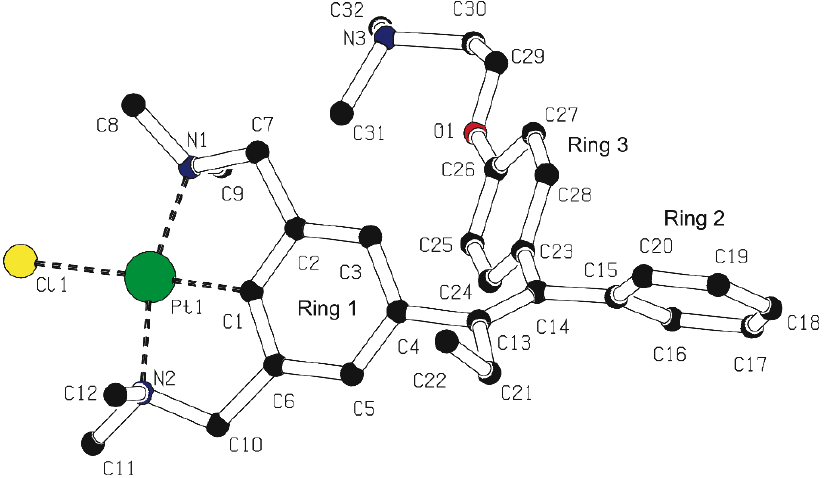
Figure 2. PLUTON visualization of 5b in the crystal [34]. Hydrogen atoms are omitted for clarity. In 5b , angles of 74.9(7), 48.6(7), and 88.4(6)° are found between the planes of ring 1 and ring 2, ring 1 and ring 3, ring 2 and ring 3, respectively. A dihedral angle of 52.5(7)° is found between ring 1 and the plane formed by C4, C13, C14, C21. Angles of 48.8(9) and 56.9(9)° are found for ring 2 and ring 3, respectively, with the plane formed by C13, C14, C15, and C23. The phenyl rings are not coplanar with the ethylene bond C13-C14, and an angle of 6.4(9)° is found between the planes formed by C4, C13, C14, C21, and C13, C14, C15, C23, which both contain the ethylene fragment.